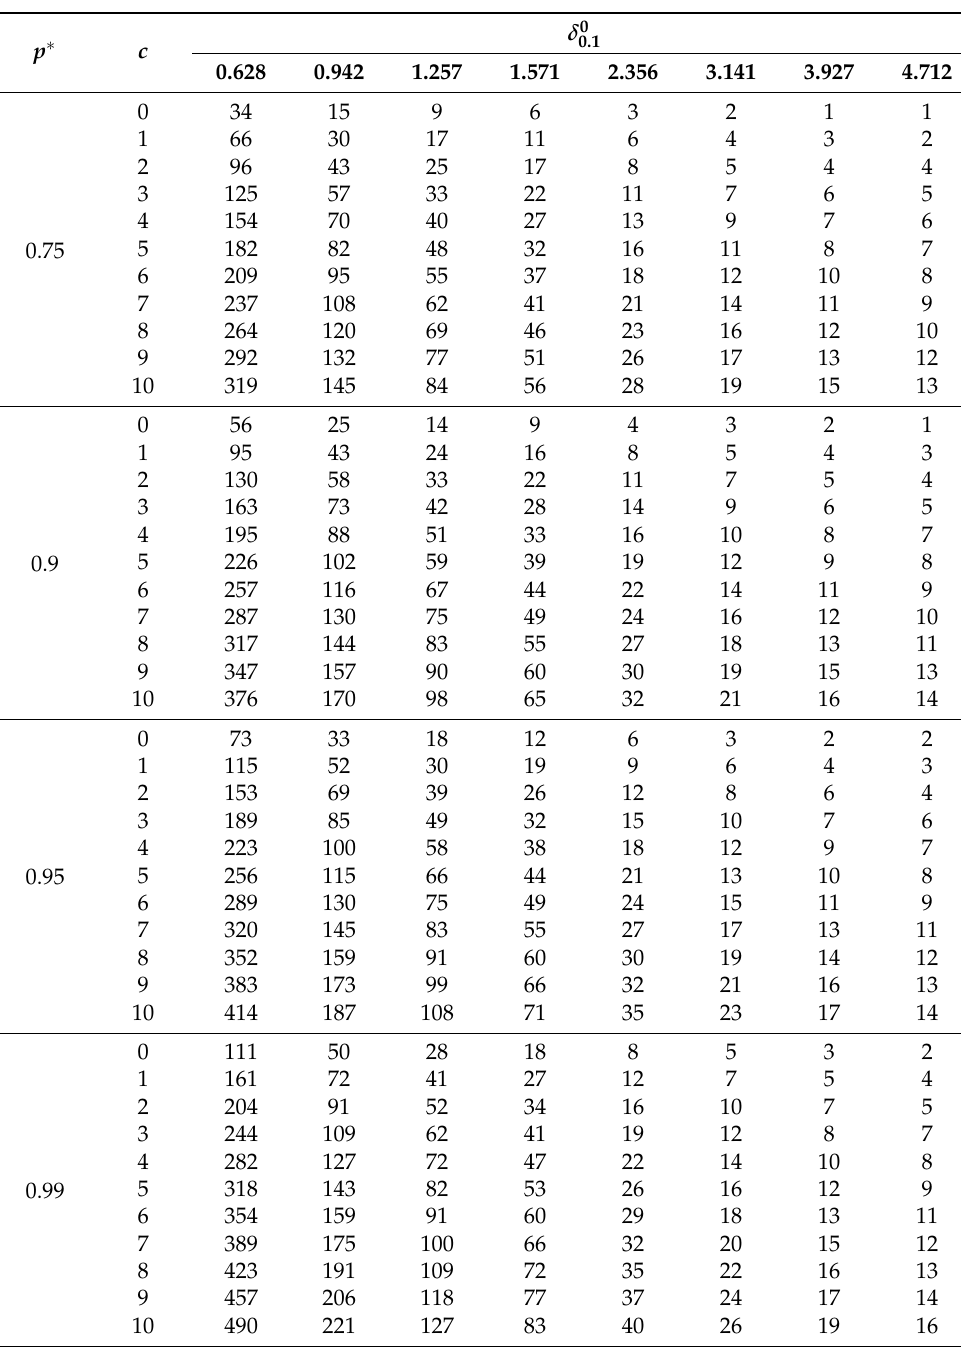
Table 2. Minimum sample sizes necessary to assure the percentile q = 0.1 life of a product to exceed a given t 0 with η = 2 and α = 2 for the 0.1